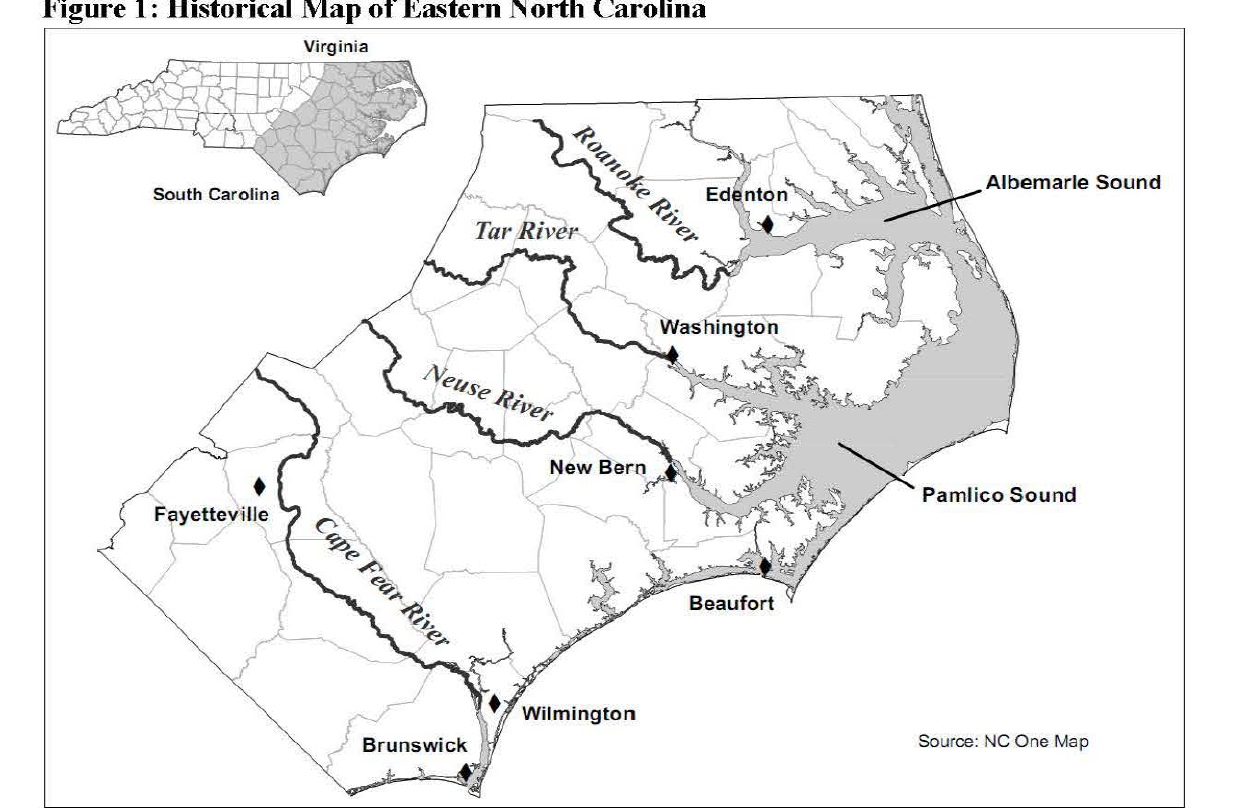
Figure 1: Historical Map of Eastern North